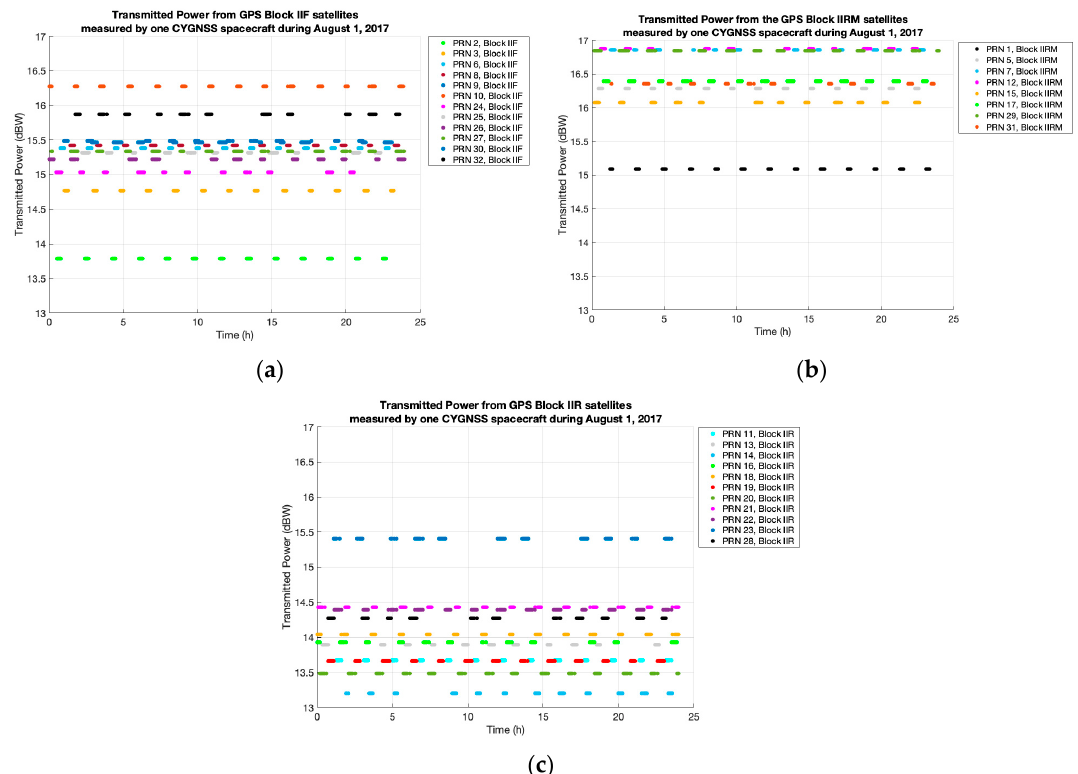
Figure 5. GPS transmitted power P tx for the 32 satellites of the constellation. The information is in the variation range of those transmitted power. Each color corresponds to a different GPS satellite. ( a ) GPS block IIF satellites are represented by circles, ( b ) GPS block IIRM satellites are represented by squares, and ( c ) GPS block IIR are represented by crosses.